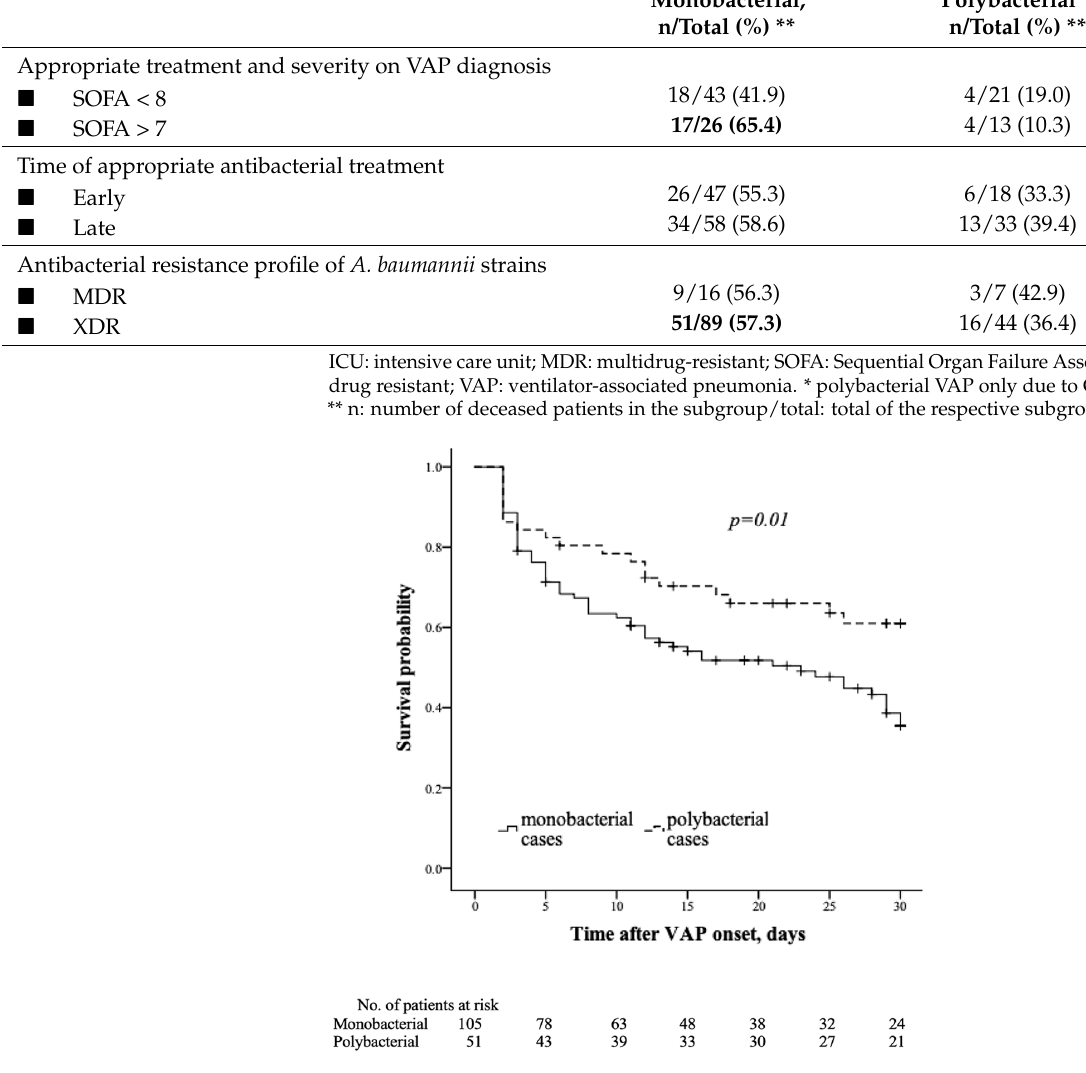
Figure 1. Kaplan–Meier survival curves for time to death in monobacterial vs. polybacterial VAP due to MDR A. baumannii (censored at 30 days). to MDR A. baumannii (censored at 30